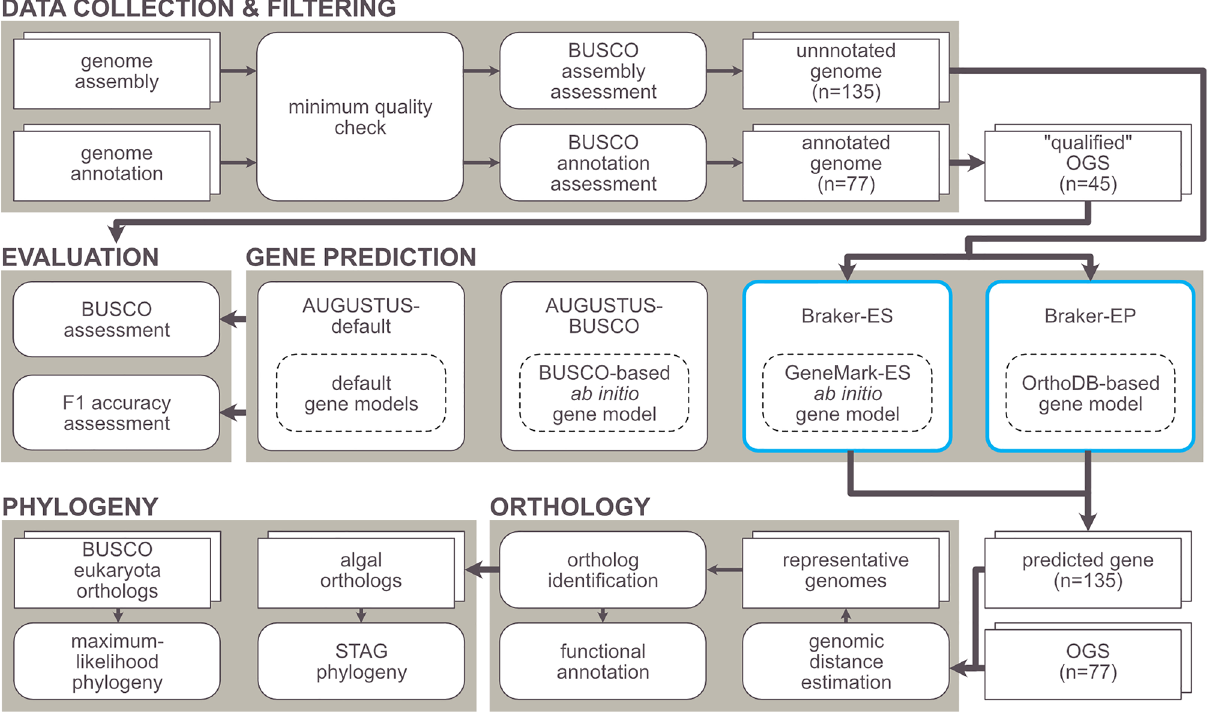
Figure 1. Flowchart of the present study. OGS denotes official gene